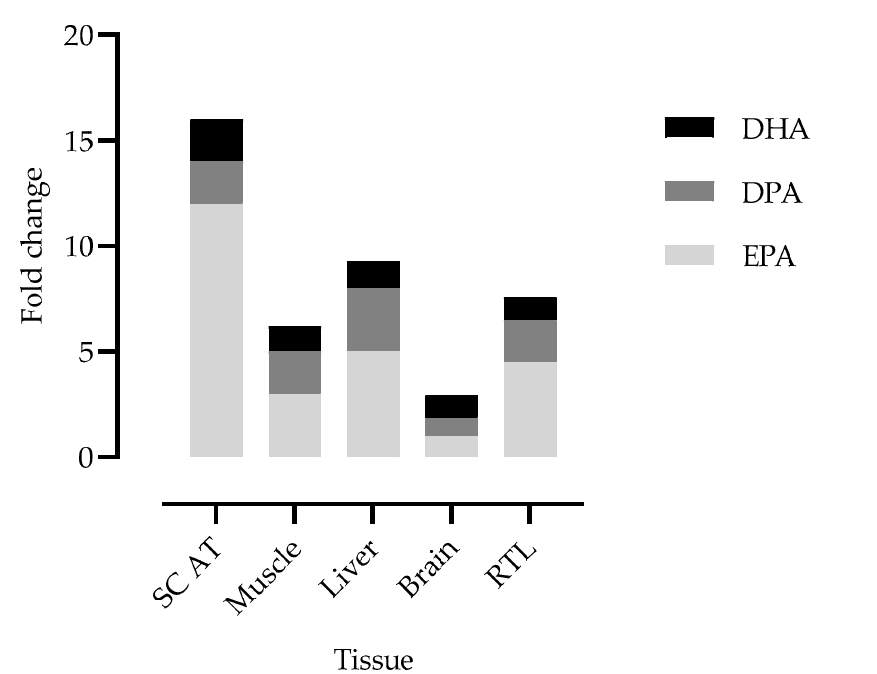
Figure 4. EPA, DPA and DHA fold change in lambs’ tissues. The fold change was calculated between the mean value determined in the tissues of freeze-dried Nannochloropsis oceanica -fed lambs versus the mean value for control-fed lambs. SC AT: subcutaneous adipose tissue; RTL: retina and tapetum lucidum . The reference value for the brain corresponds to the mean of all brain parts.